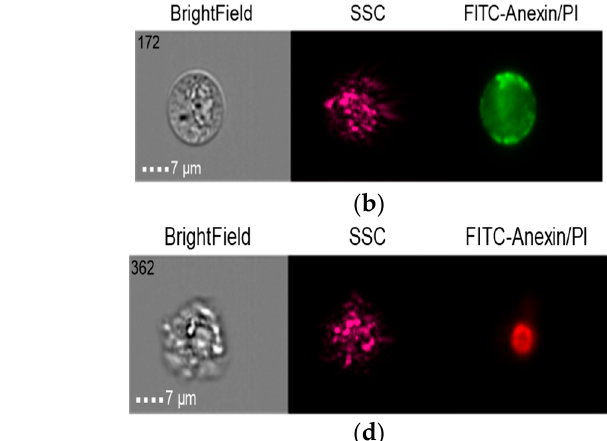
Figure 15. Live cells ( a ), late apoptosis ( b ), necrosis ( c ) after co-culture of THP-1 cell line with Nobel Replace NSMP induced by lipopolysaccharide (Nobel Replace NSMP + HDS + LPS + THP-1). It should be noted that early-cell apoptosis could not be detected in this control sub-